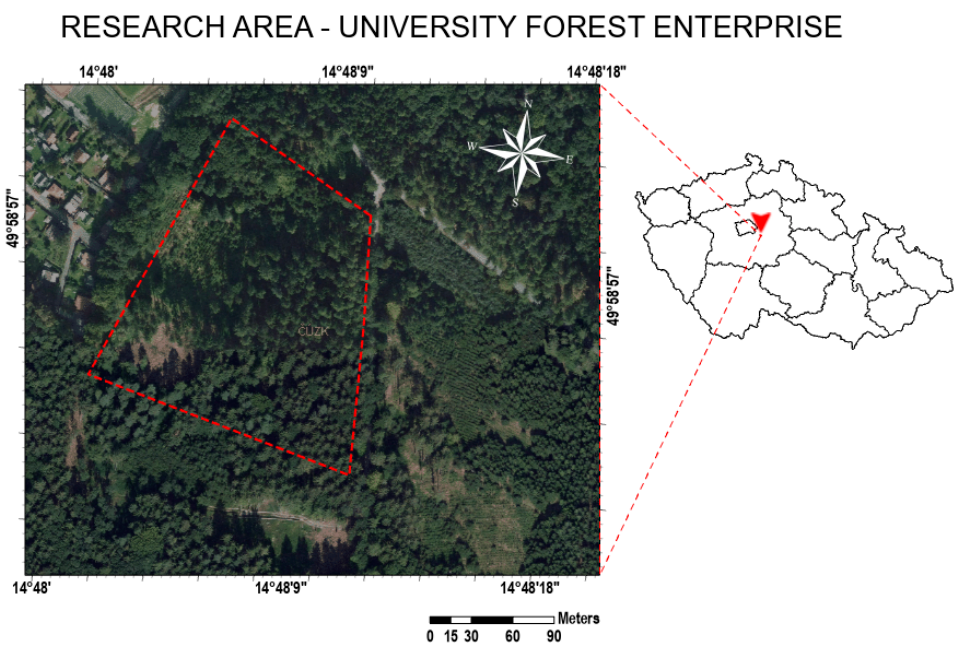
Figure 2. Location of study plot in Vyžlovka, Czech Republic, in a coordinate system S-JTSK Krovak East North, data source: Č ÚZK.